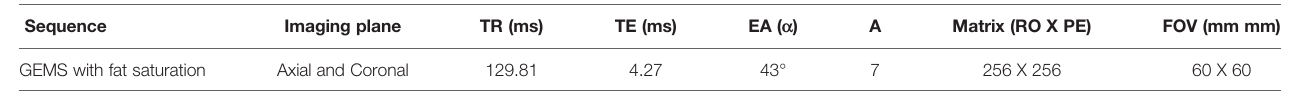
TABLE 1 | MRI sequence protocol and